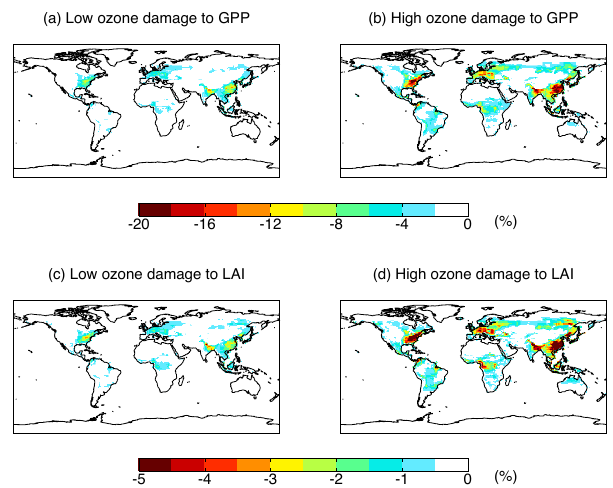
Figure 9. Percentage of ozone vegetation damage to (top) GPP and (bottom) LAI with (a, c) low and (b, d) high sensitivity. Both dam- ages of GPP and LAI are averaged for 1982–2011. Offline surface ozone concentrations (Fig. S5) are simulated by the GISS ModelE2 with climatology of the year